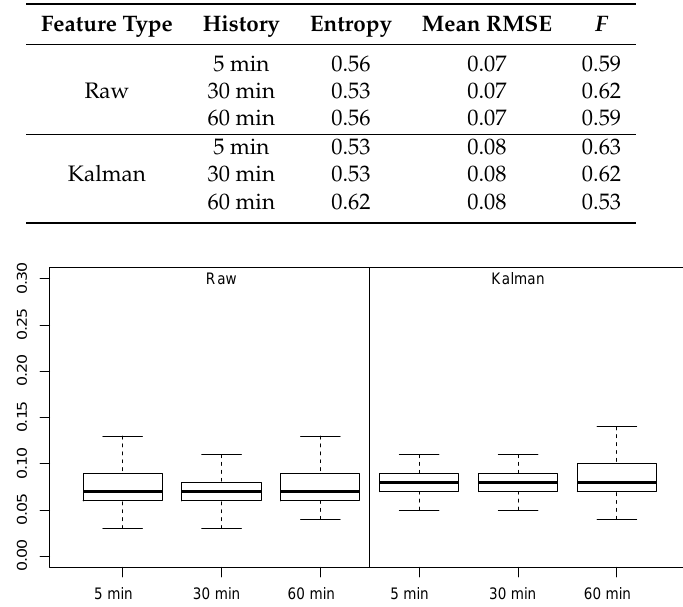
Figure 8. Boxplots of the baselines, considering one model for each road